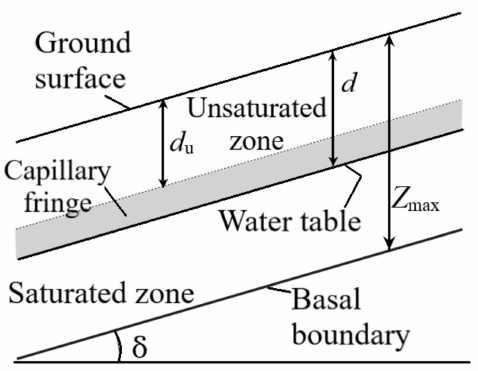
Figure 2. One-cell sketch for the transient rainfall infiltration and grid-based regional slope-stability model (TRIGRS) model